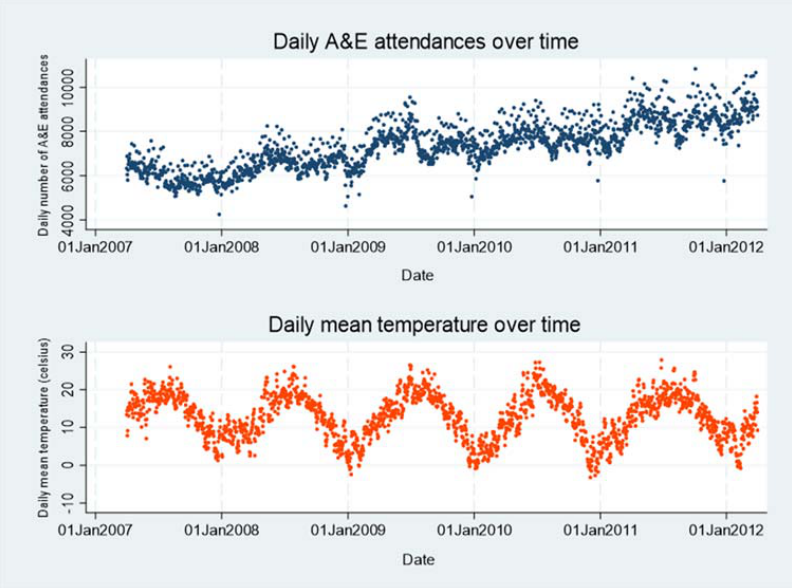
Figure 1. Raw plots showing Accident & Emergency (A&E) department attendances and mean temperature data over the five ‐ year study period in Greater